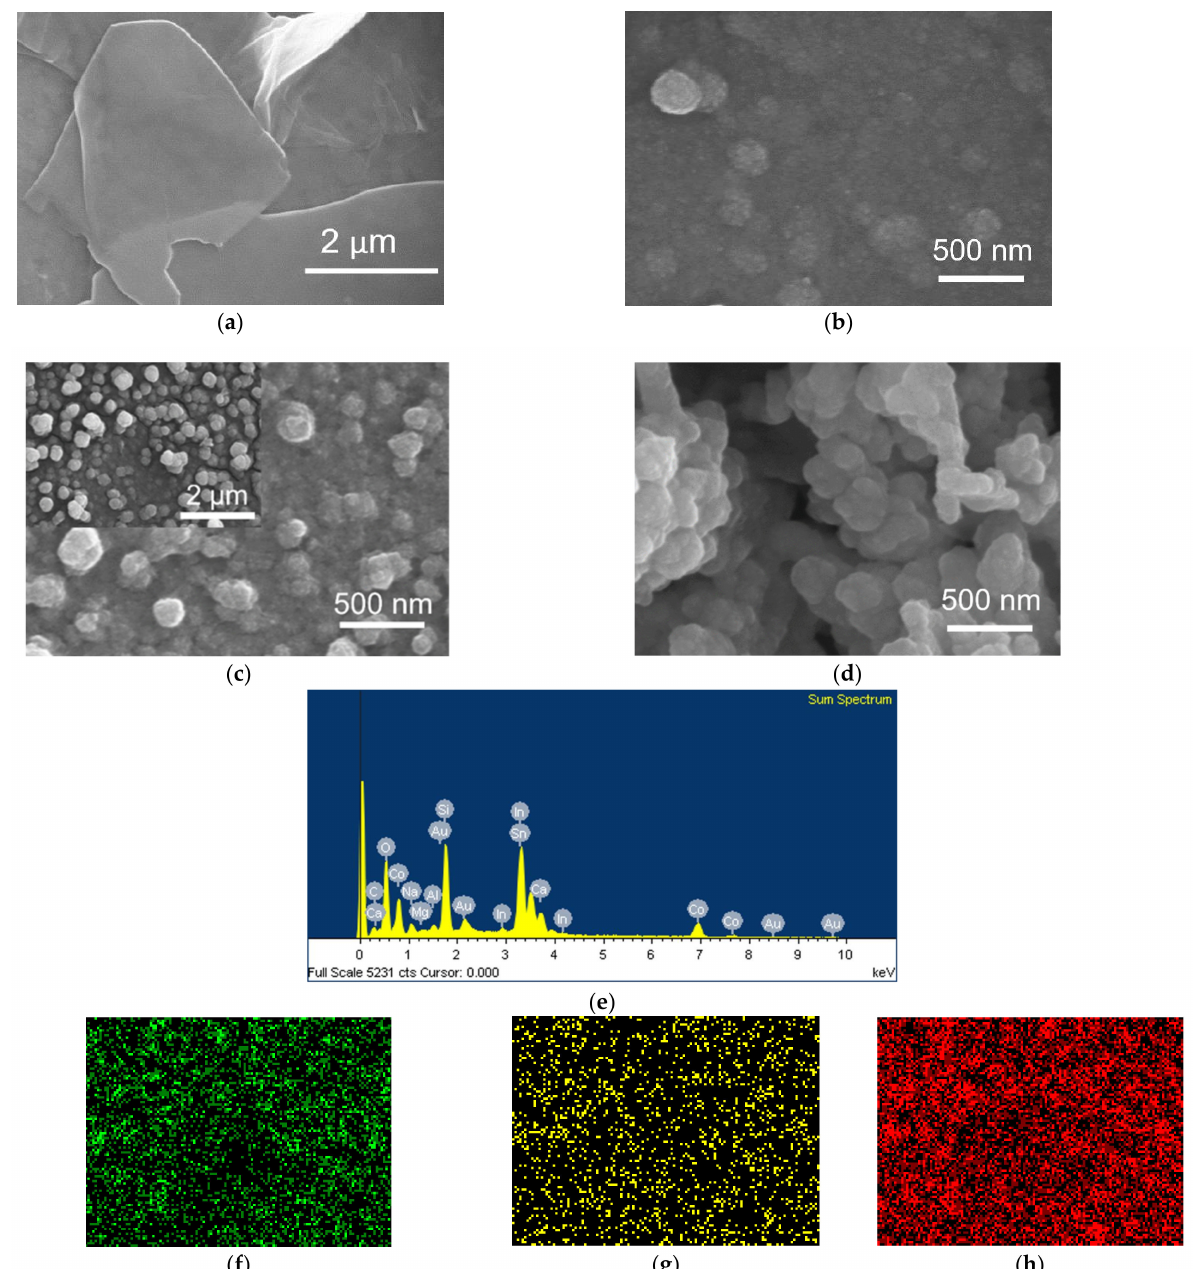
Figure 2. XRD patterns of rGO and Co 3 O 4 /rGO composites.